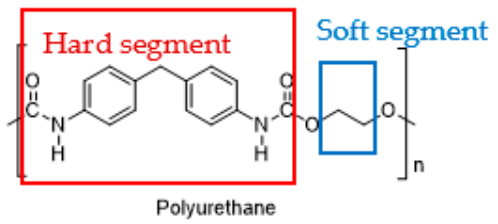
Figure 9. The hard segment (red) and soft segment (blue) of polyurethane.